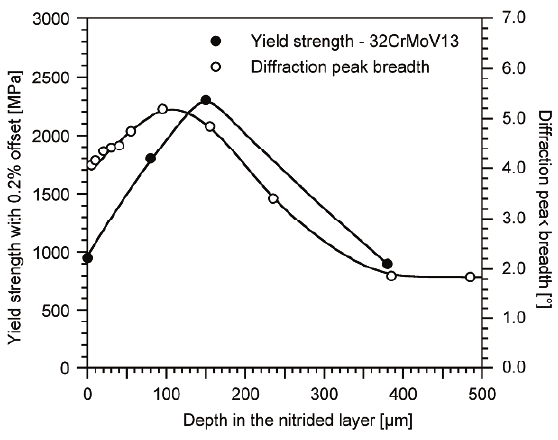
Figure 7 – In-depth yield strength and X-ray diffraction peak breadth in the DIN 32 Cr Mo V 13 steel.